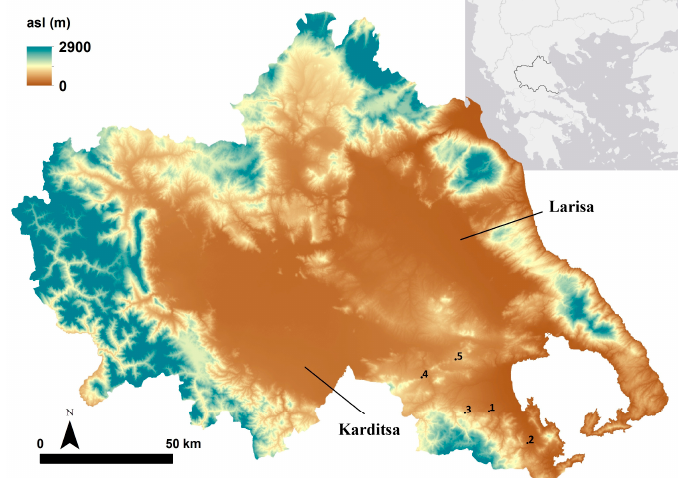
Figure 1. Thessaly is located in Central Greece. Larisa Basin in the east and Karditsa Basin in the west forms the majority of region; these basins are separated by low hills. Sites under investigation are: (1) Almyros 2; (2) Kamara; (3) Karatsantagli; (4) Perdika 2; and (5)